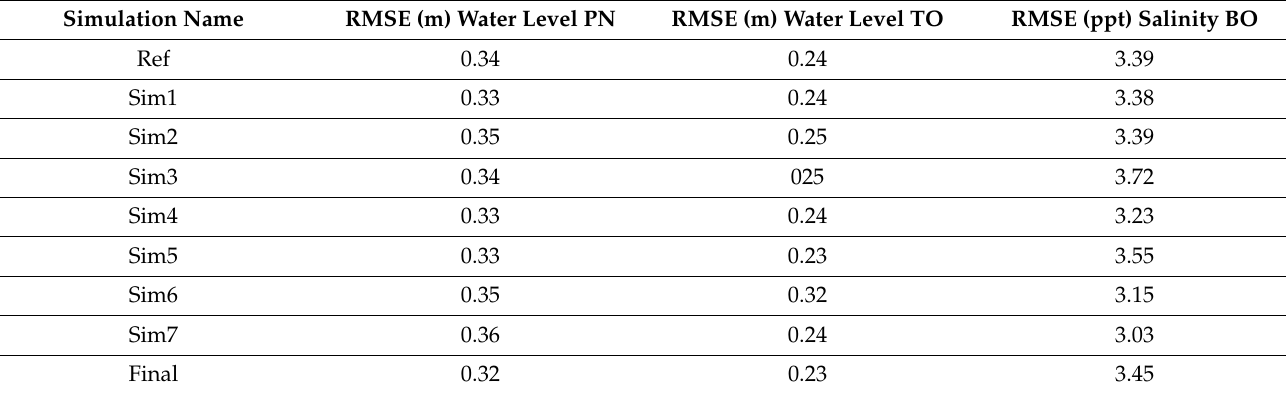
Table A2. Statistics for the calibration period (July 2010), for water levels at PN and TO and salinity at BO.